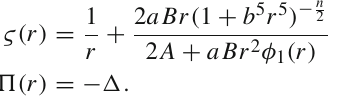
Fig. 8 (Top) In this figure, along x -axis, y -axis and z -axis we have respectively plotted the radius of the star in km unit, the dimensionless quantity n which lies in the range − 200 ≤ n ≤ 200 and the radial adiabatic index (cid:15) r which is a dimensionless quantity. (Bottom) Along x -axis, y -axis and z -axis we have respectively plotted the radius of the star in km unit, the dimensionless quantity n which lies in the range − 200 ≤ n ≤ 200 and the transverse adiabatic index (cid:15) a dimensionless quantity. Both the profiles are drawn for a compact star of mass M = 1 . 85 M (cid:3) and radius of the star=9 . 5km by fixing b = 0 . 0095 km −